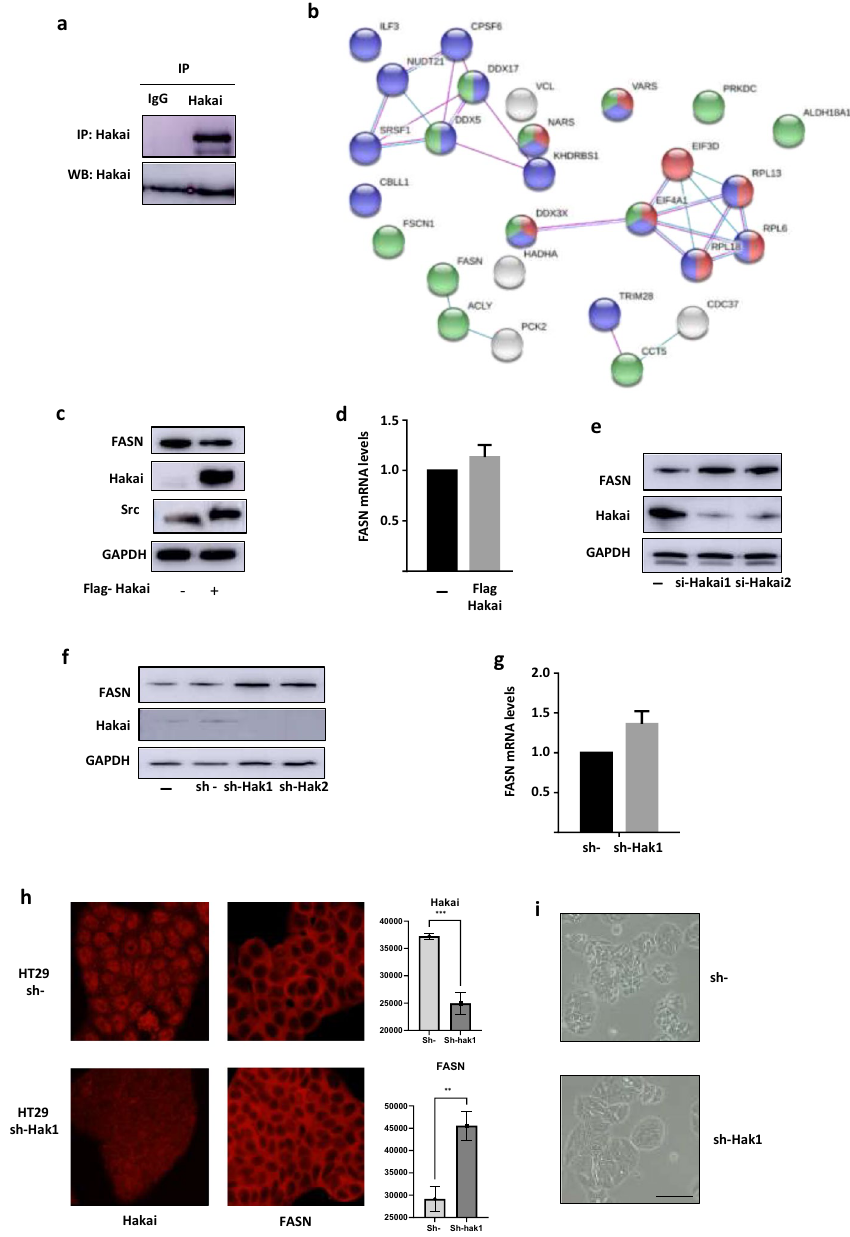
Figure 3. FASN is a novel identified protein in the Hakai interactome analysis. ( a ) Immunoprecipitation of endogenous Hakai in HCT116 cells. ( b ) Network using STRING database of all the identified proteins in Hakai immunoprecipitation in HCT-116. Proteins in green are related to drug binding, red colour, implication in translation and blue colour in RNA processing. ( c ) Effect of Hakai overexpression reduces FASN protein levels. Transfection with pcDNA-Flag-Hakai (2 µg) and pSG-v-Src (0.5 µg) was performed in HCT116 cells following by western blot with the indicated antibodies. ( d ) Effect of Hakai overexpression, as described in C, in FASN mRNA levels analysed by RT qPCR using RPL13A and GAPDH as control ( e , f ) Effect of Hakai silencing on FASN using transient transfection in HCT116 cells ( e ) or an inducible viral-transduced system with 1 µg/ ml doxycycline for Hakai silencing in HT29 ( f ). Cell lysates were subjected to Western Blotting as described. ( g ) mRNA levels of FASN determined in the inducible viral-transduced system for Hakai silencing in HT29, analysed by RT qPCR using RPL13A and GAPDH as a housekeeping controls. ( h ) Effect of Hakai silencing in FASN subcellular localization in the inducible viral-transduced system in HT29 cells. Immunofluorescence images with anti-Hakai and anti-FASN antibodies (left panel) and quantification (right panel) is included. Images taken with 40X magnification. ( i ) Effect of Hakai on phenotype by using an inducible silencing viral system on HT29 cell. Optical microscopy images taken after 72 h induction. Scale bar 125 μm. The blots images were cropped prior hybridization and original blots are included in Supplementary